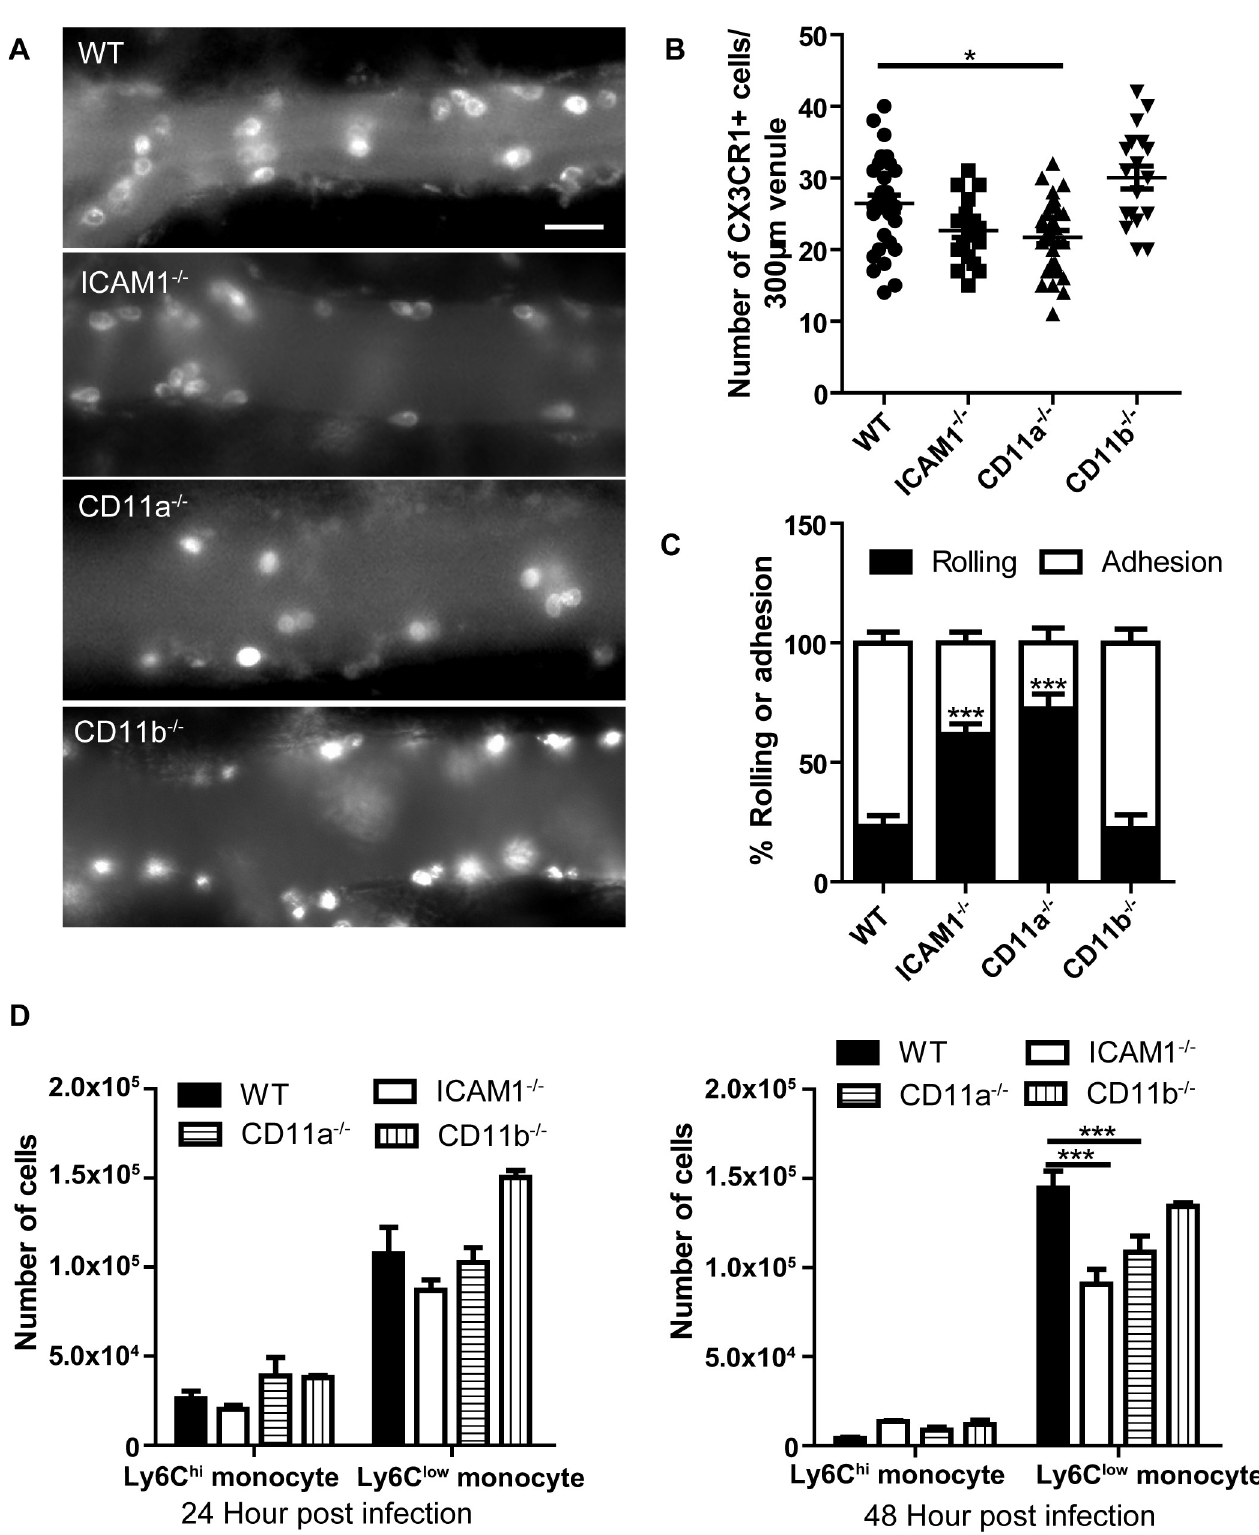
Fig 4. ICAM1 and CD11a but not CD11b are partially involved in monocyte recruitment to the brain vasculature. (A) Representative IVM images showing the recruitment of CX3CR1 + monocytes in brain postcapillary venules of WT, ICAM1 -/- , CD11a -/- , and CD11b -/- mice 24 h after i.v. infection with